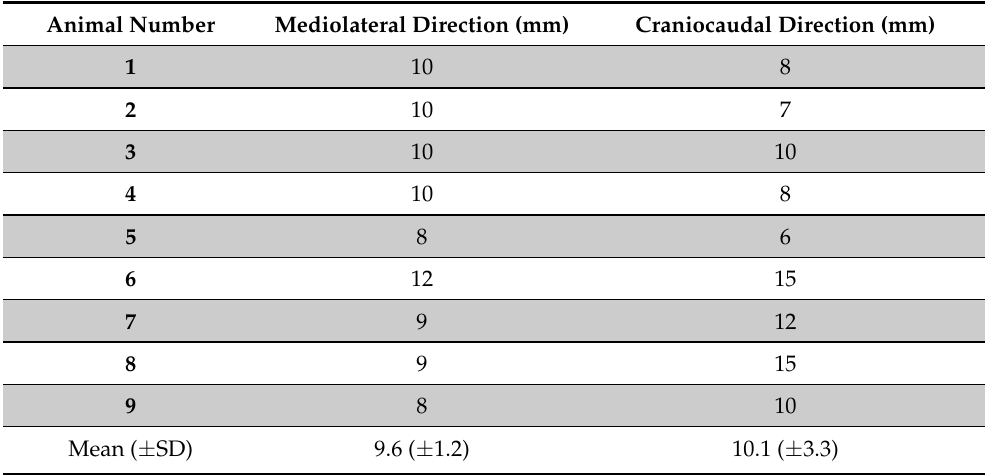
Table 1. Measured distance between the tip of the manubrium and the origin of the right com- mon carotid artery at the brachiocephalic trunk in a mediolateral direction (SD ± 1.2 mm) and a craniocaudal direction (SD ± 3.3 mm).